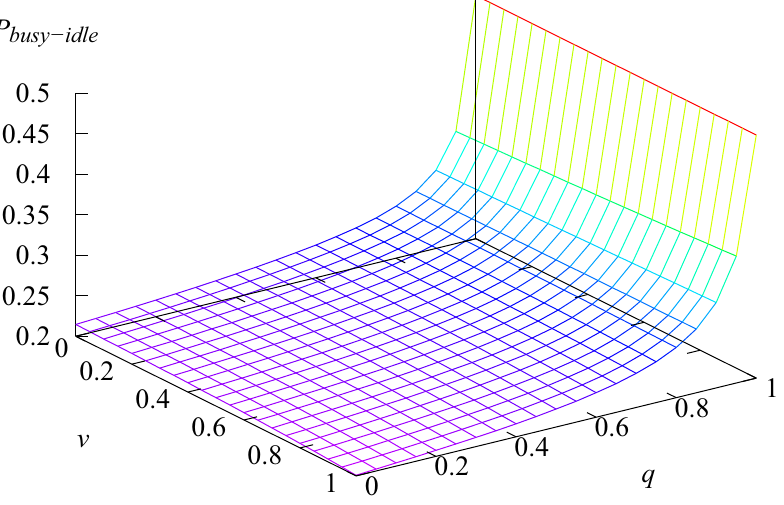
Figure 12. Dependence of the probability P busy − idle that the main server is busy while the secondary server is idle on the parameters q and ν